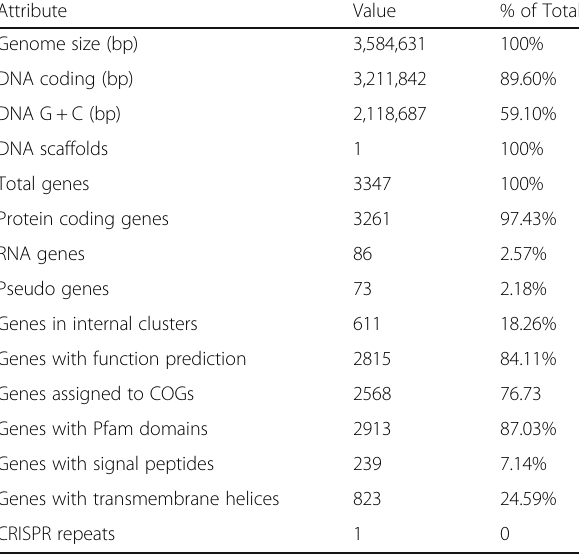
Table 3 Genome statistics